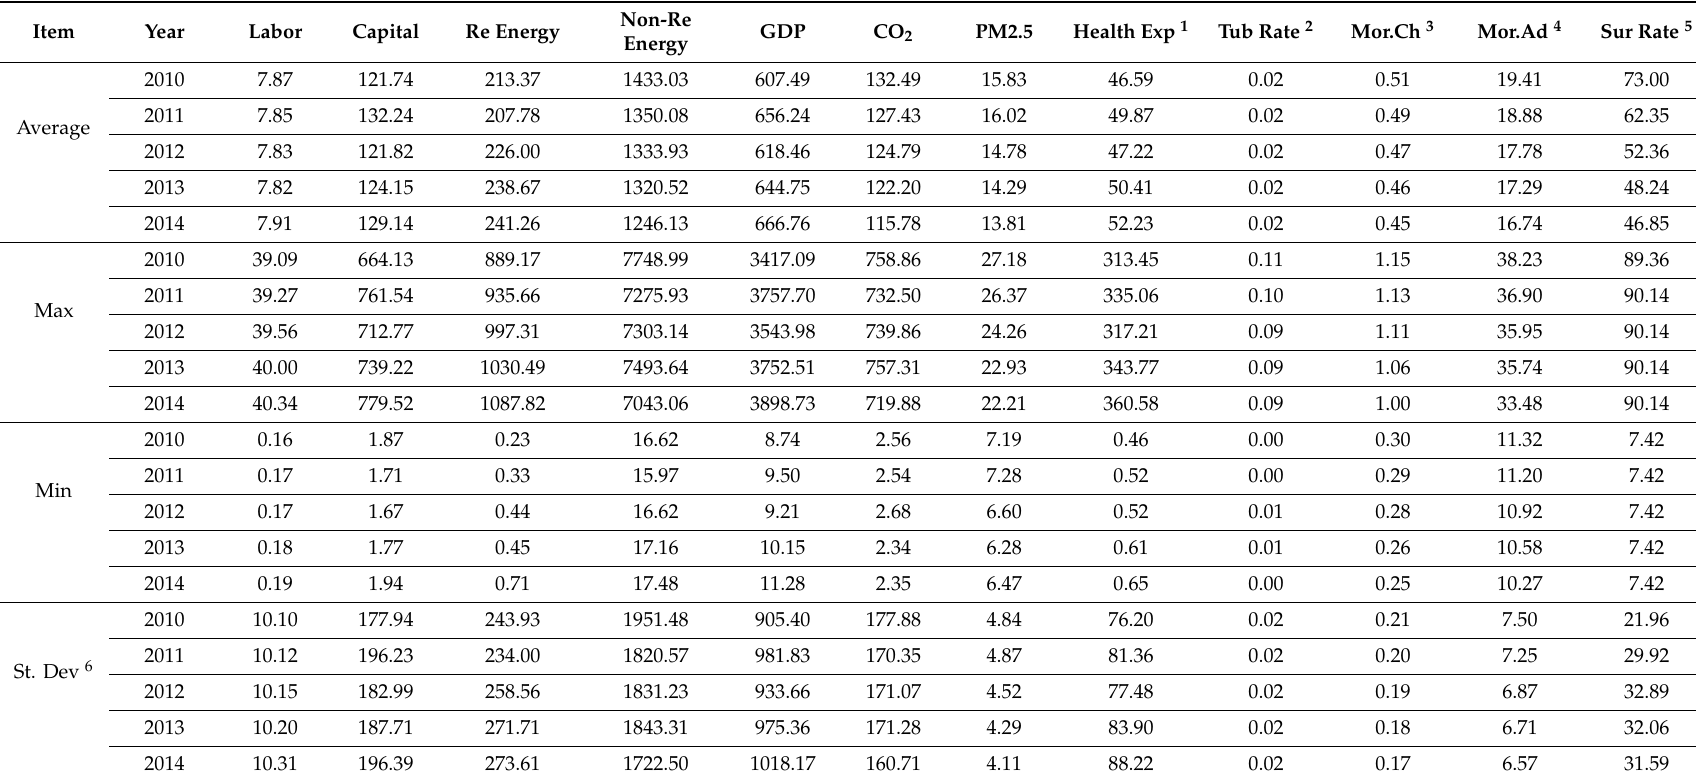
Table 3. Statistics of input and output variables of EU